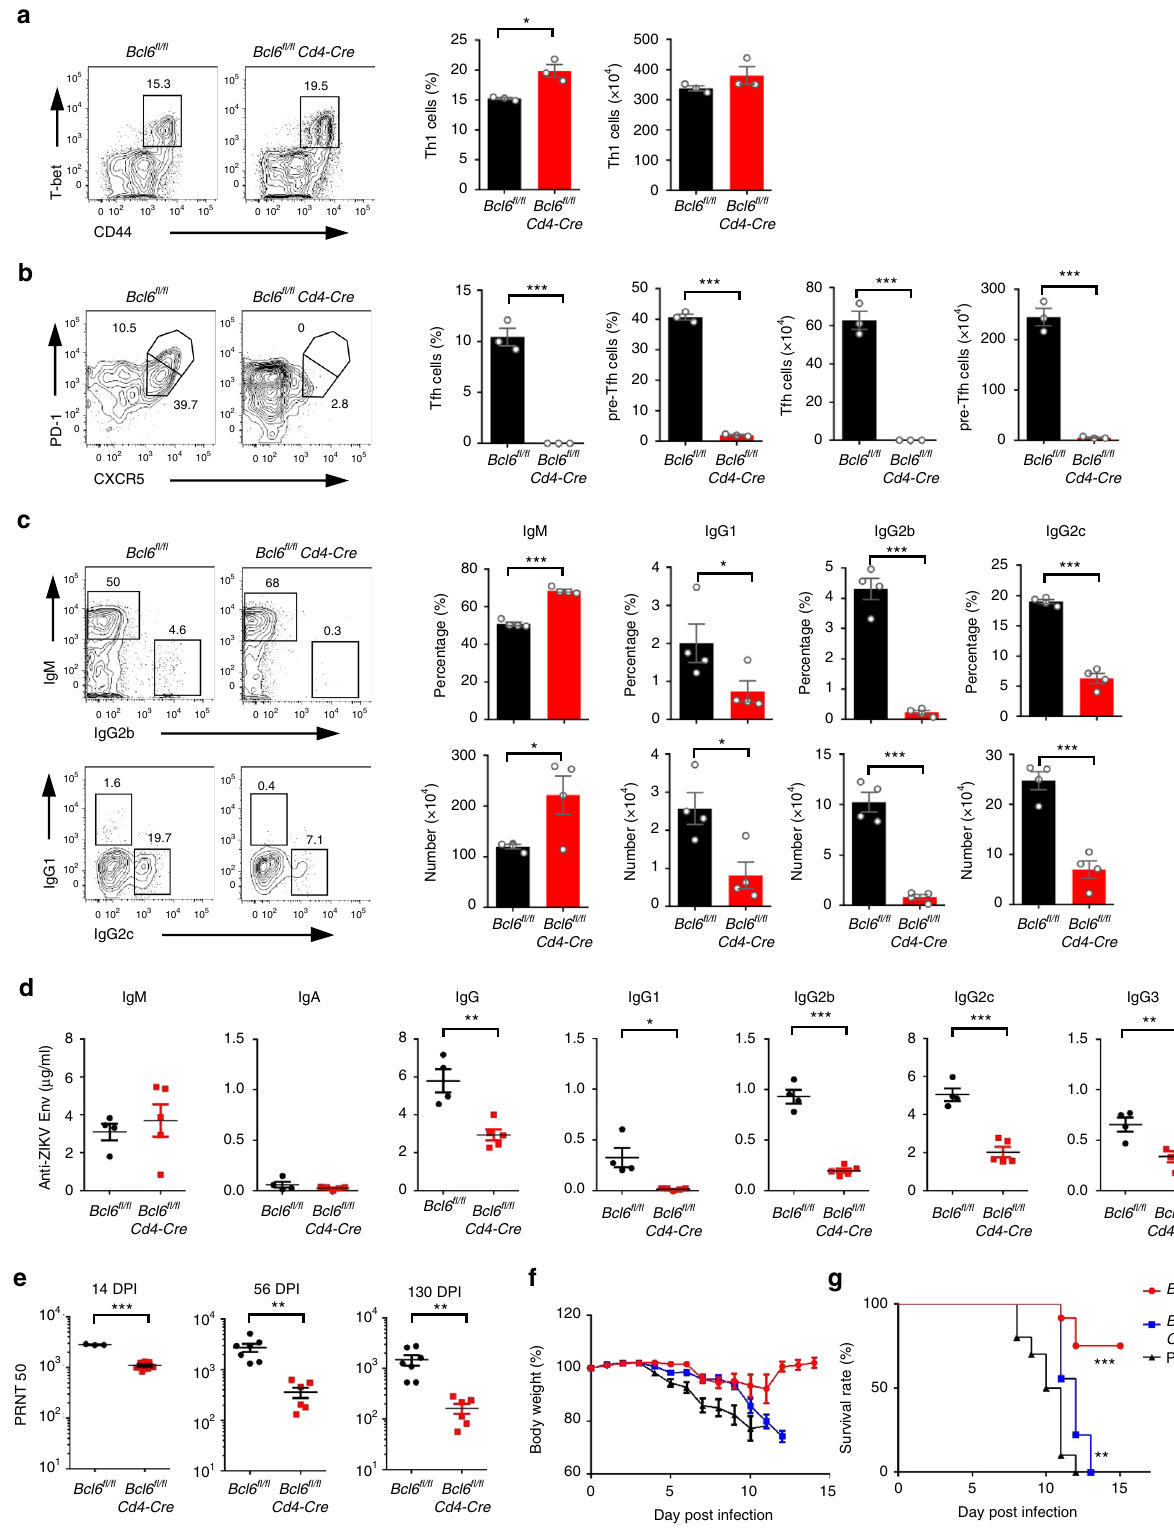
with WT : Bcl6 fl / fl Cd4- Cre mixed bone marrow chimeras (Fig. 6d, e). Consistent with observation in Tbx21 − / − mice, IgG1 producing cells and the level of ZIKV envelope speci fi c IgG1 in sera markedly increased in Tbx21 − / − : Bcl6 fl / fl Cd4- Cre mixed bone marrow chi- meras (Fig. 6d, e). Our data suggested that Th1-like Tfh and